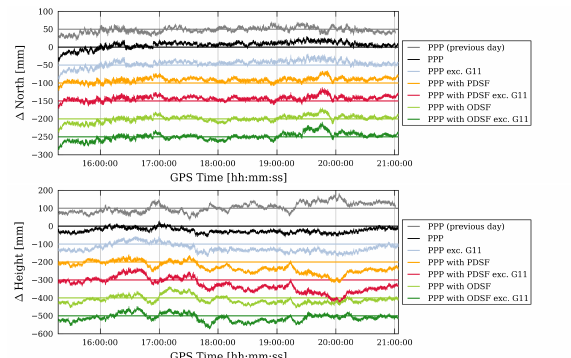
Figure 13: Northing (top) and height (bottom) errors between 15:17 and 21:04 (GPS system time) on August 31 2013 for receiver UCL re- sulting from standard PPP processing both with (black) and without (blue-grey) measurements from the satellite G11 on day 2. Similarly shown in other colors are the errors resulting from PPP processing with position- or observation-domain sidereal filters applied. Each of the time series have been offset from each other by appropriate multiples of 50 mm or 100 mm for